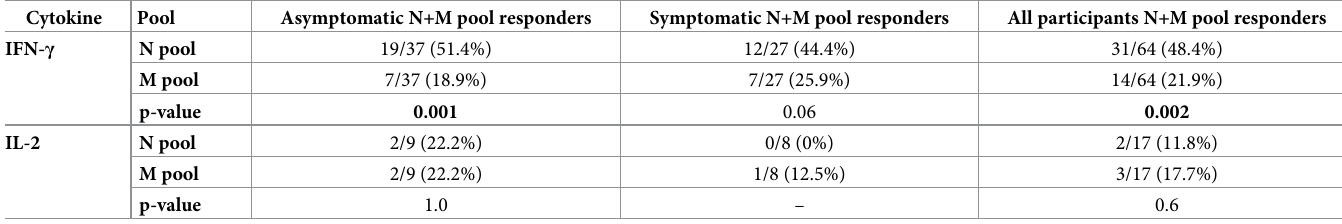
The numbers and percent positive of asymptomatic and symptomatic participants with positive IFN- γ or IL2 responses post-infection to the N+M pool were compared with responses to the individual N or M pools.